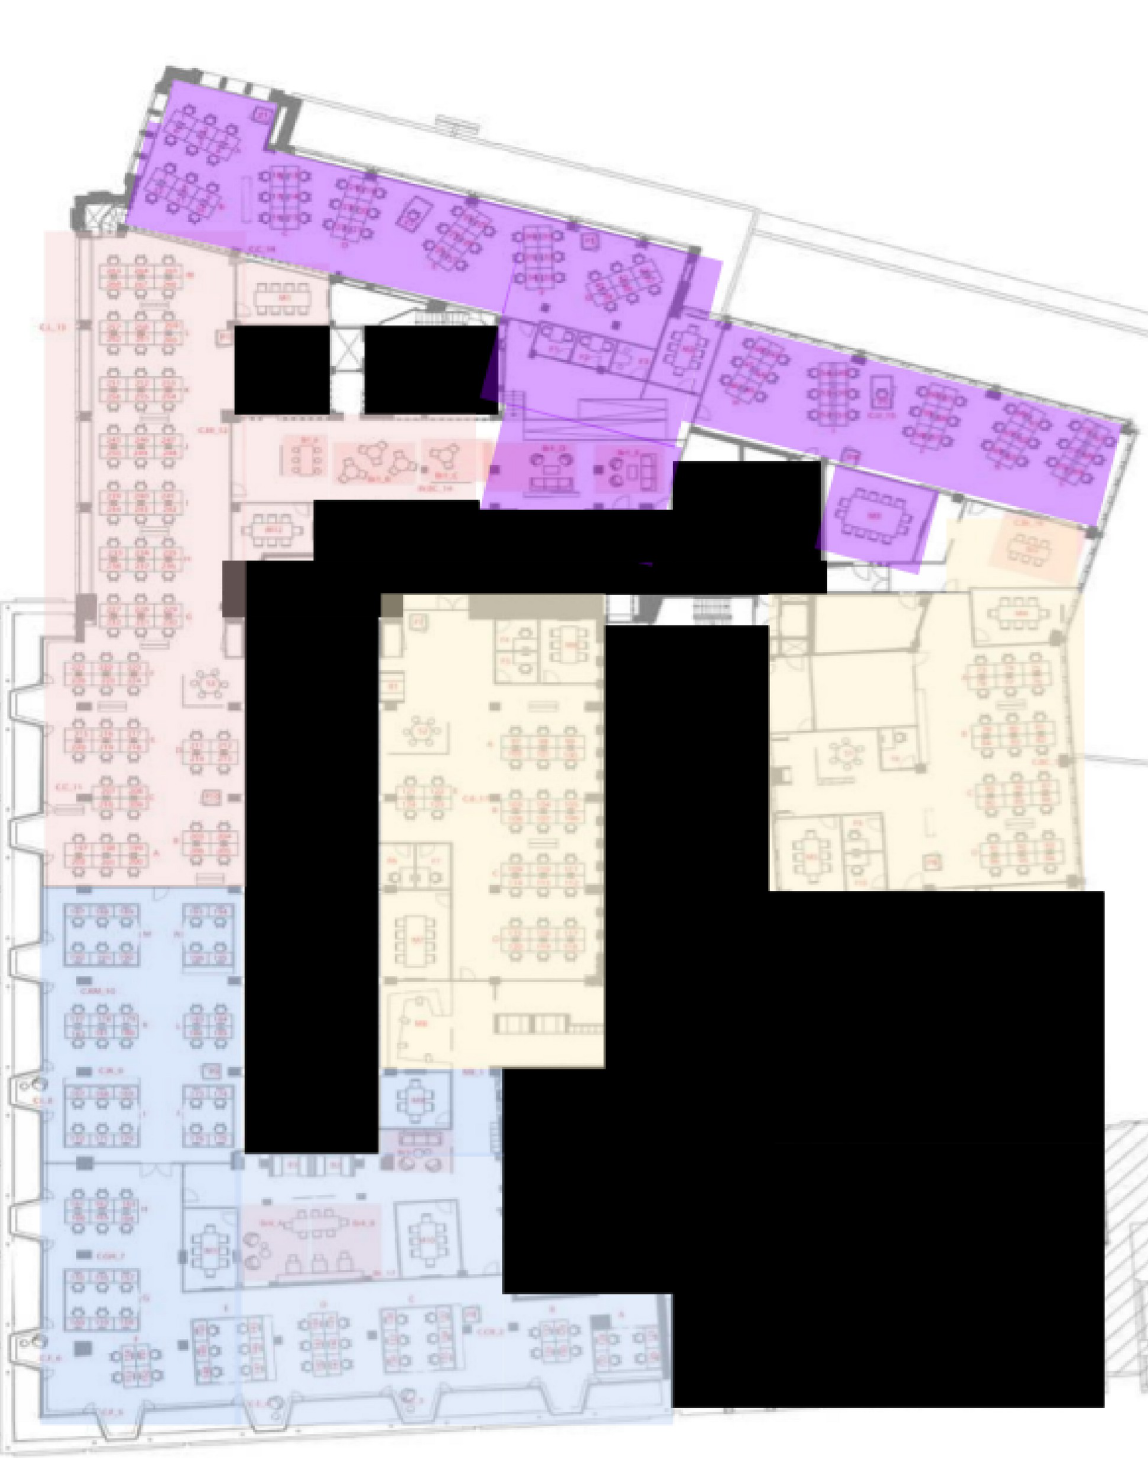
PLOS ONE | https://doi.org/10.1371/journal.pone.0232943 May 19, 2020 8 /